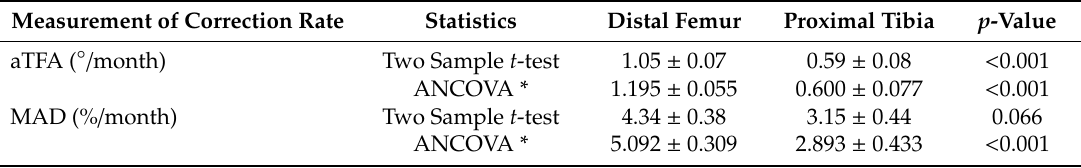
Table 8. Comparison of correction rates between the group screwed at the distal femur and proximal tibia, before and after adjustment by